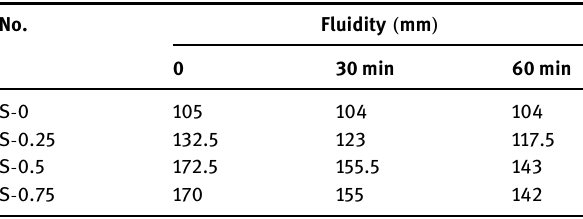
Table 3: Fluidity of cement paste added with di ff erent dosages of nano - C – S –